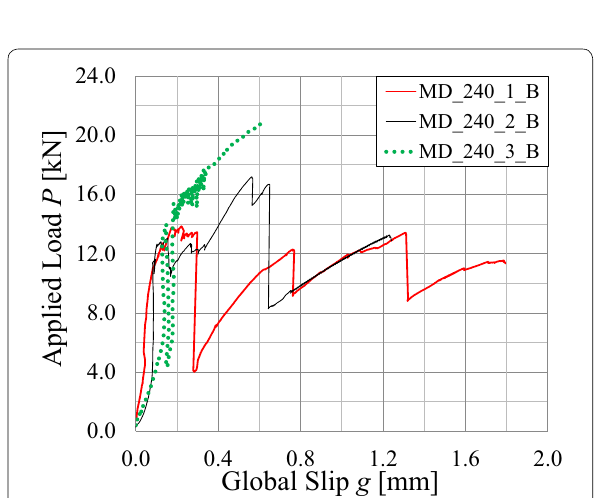
Fig. 9 Load responses of single-lap shear specimens with MD fibers, bonded length L 240 mm, and bare fibers outside the bonded area =